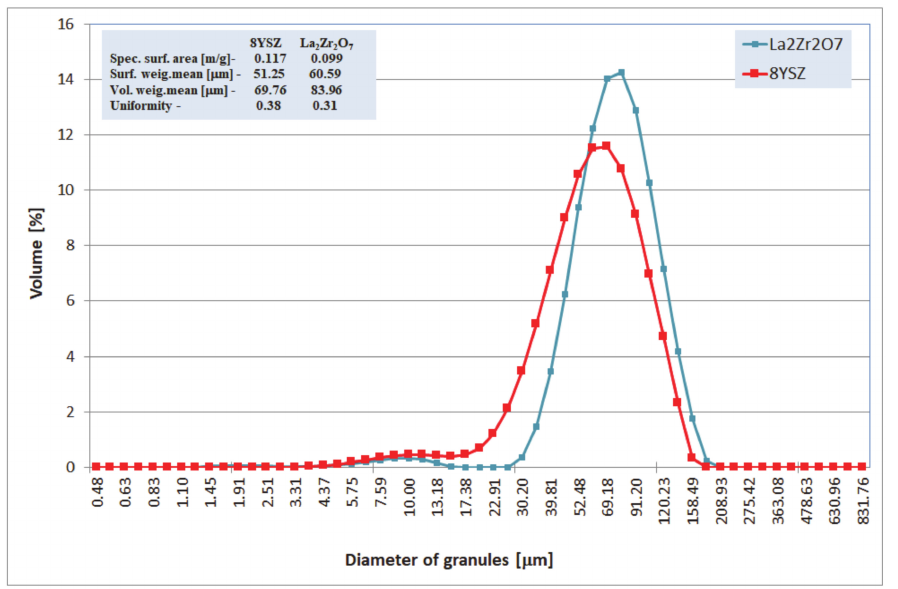
Figure 4. Characterization of La 2 Zr 2 O 7 and 8YSZ powder size distributions.